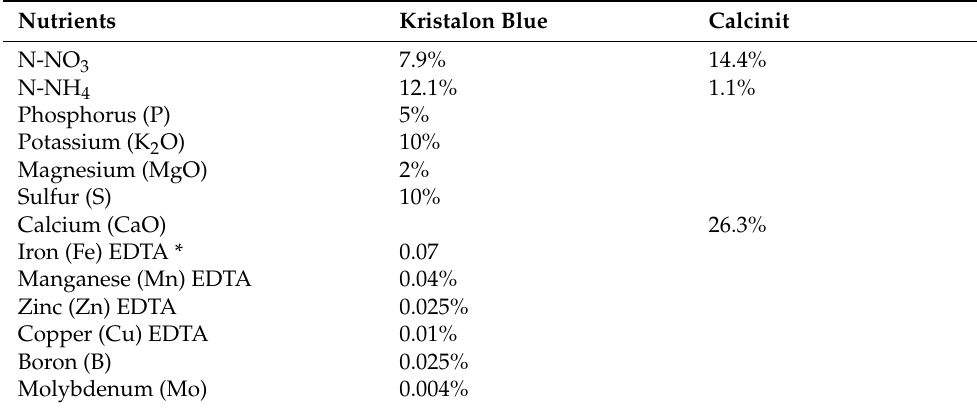
Table 3. A standard stock solution of nutrients at a 0.25% ( v / v ) dilution rate used in the